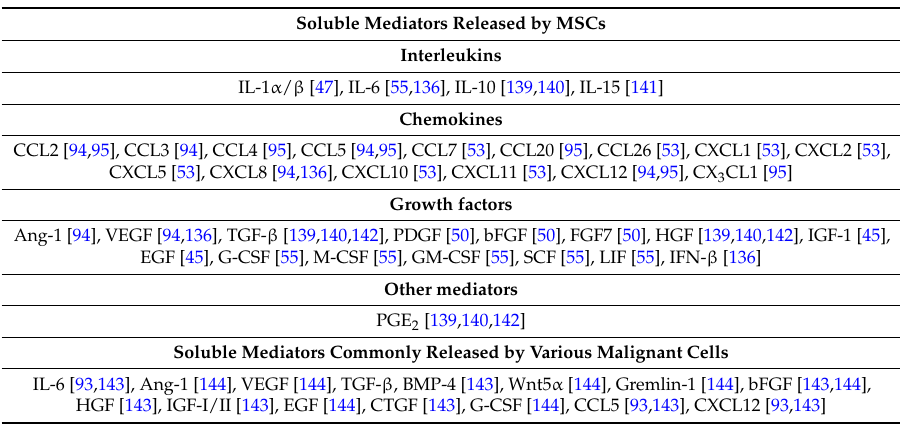
Table 4. Cytokines released by MSCs and malignant